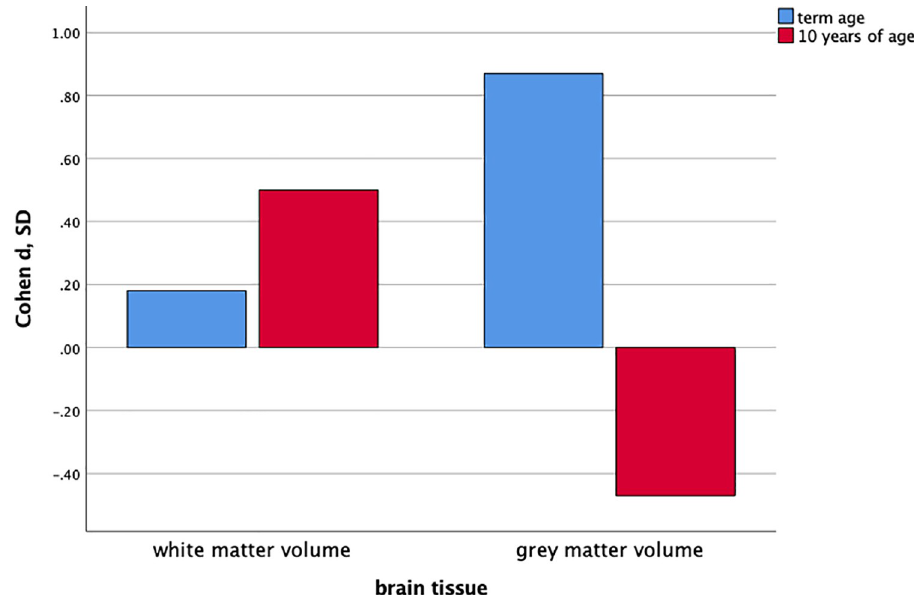
Fig 3. Effect size calculations for brain volumes at term age and at 10 years of age. Effect size (Cohen d , SD) calculations at term age (45 extremely preterm infants and 15 control infants) and at 10 years of age (51 extremely preterm children and 38 control children) for white and grey matter